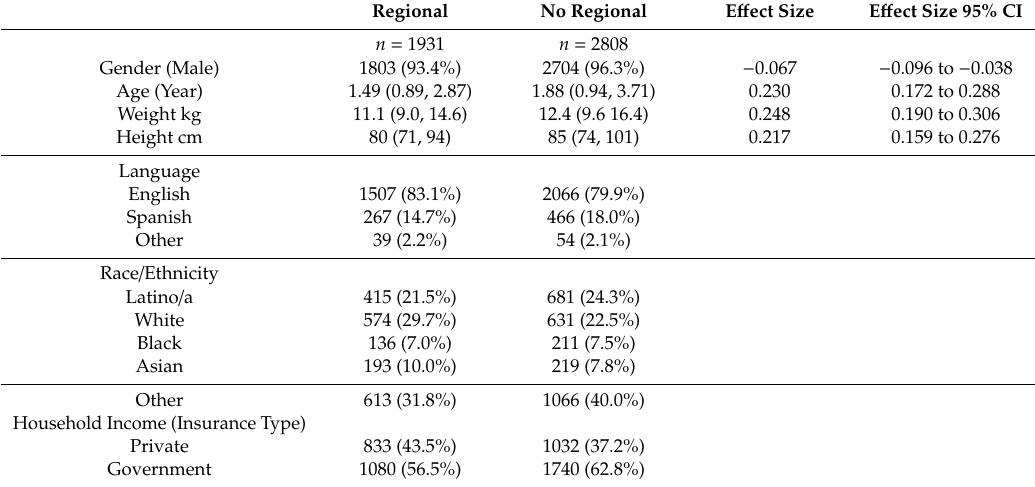
Table 1. Di ff erences between caudal regional block and no caudal regional block. Data is for each individual surgery and the patient characteristics at the time of